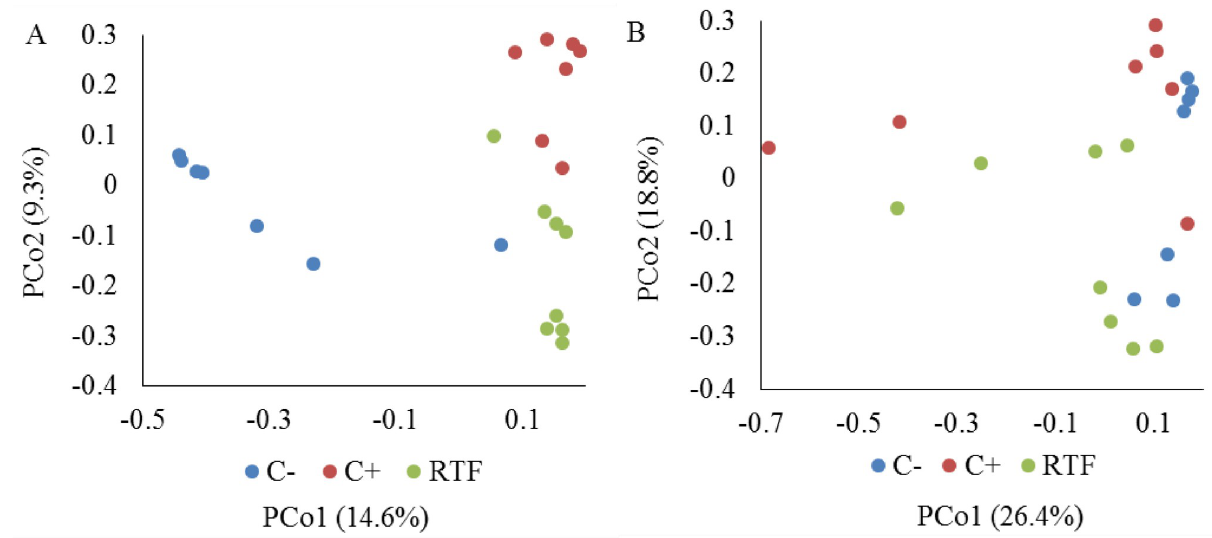
Fig 3. Principal coordinate analysis (PCoA) for bronchoalveolar lavage samples based on unweighted (A) and weighted (B) UniFrac distances. Culture-negative samples (C-) are shaded in blue, culture-positive (C+) in red, and respiratory tract flora (RTF) samples in green.